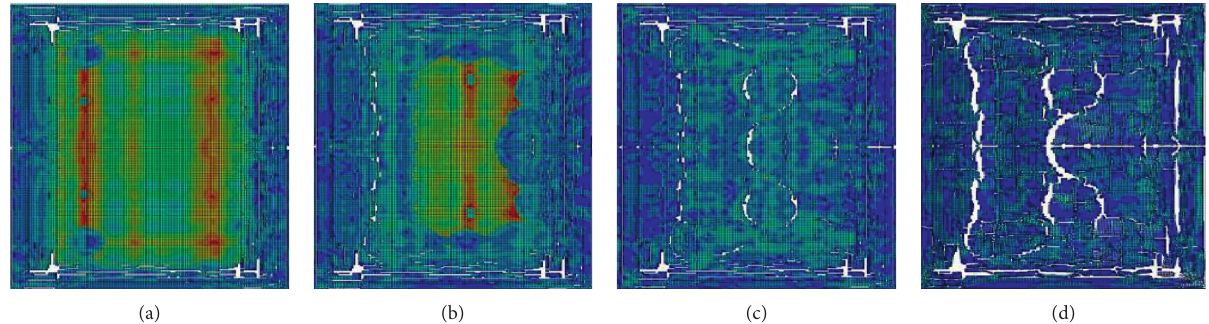
Figure 10: Dynamic damage and failure of thin plate rock mass C-C-C-C under impact load.